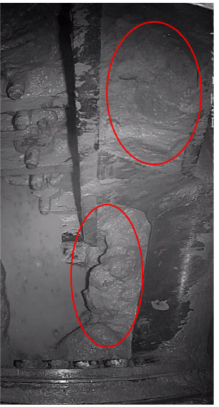
Figure 5. Soil clogging in the chamber.